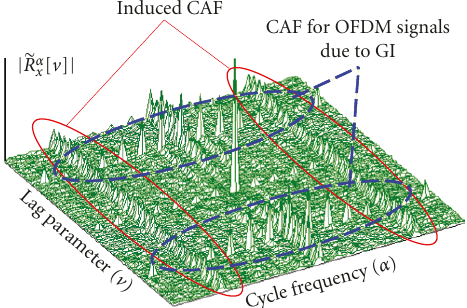
Figure 6: Illustration of CAF peak pattern after cyclostationarity induction using Method